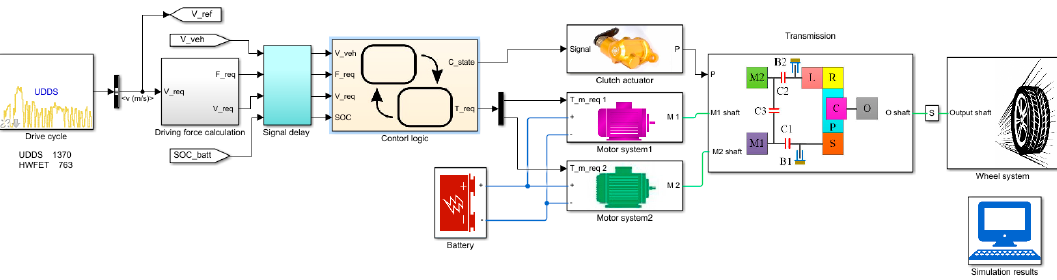
Figure 13. The simulation structure.